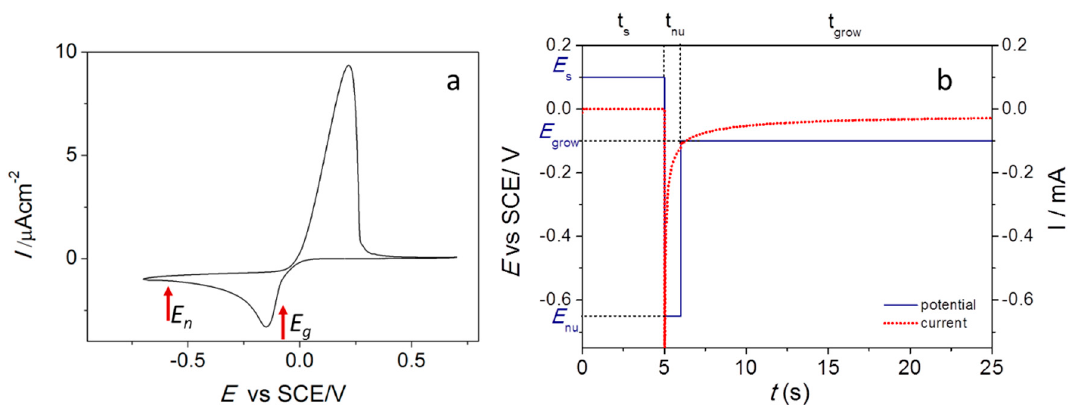
Figure 23. ( a ) Cyclic voltammetry in H 2 O + 5 mM CuSO 4 + 0.1 M LiClO 4 at glassy carbon, scan rate 0.2 V·s − 1 ; ( b ) double potential pulse for the Cu deposition applied in this study. Adapted with permission from Durante et al. [254]. Copyright (2014), John Wiley and Sons.